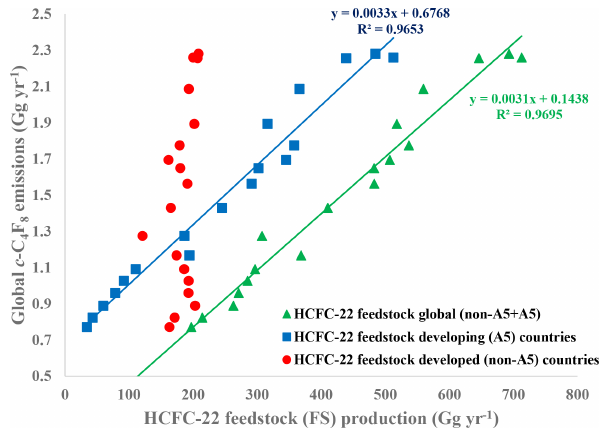
Figure 3. The relationship between A5 (developing, blue squares), non-A5 (developed, red circles) countries and total global HCFC- 22 feedstock (FS, green triangles) production and global c -C 4 F 8 (PFC-318) emissions